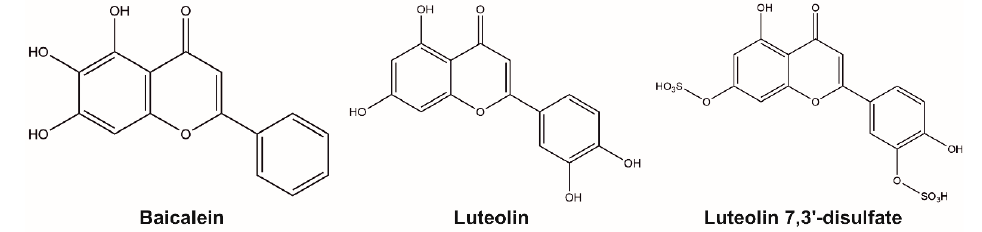
Figure 1. Flavonoids used in this work.